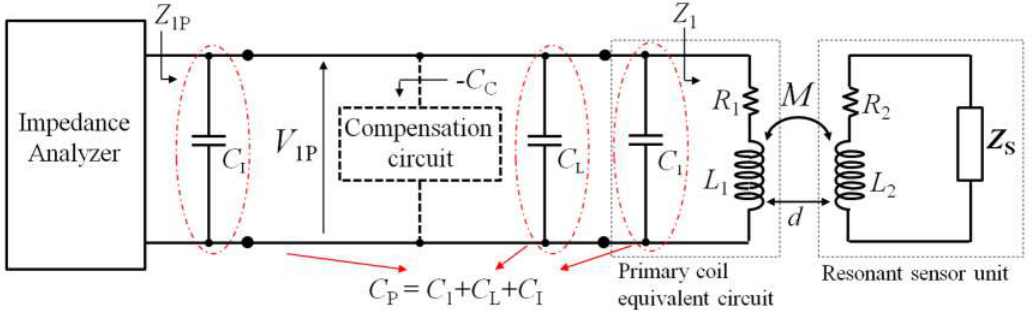
Figure 14. Block diagram of the interrogation system based on impedance measurement technique with parasitic capacitance compensation circuit.